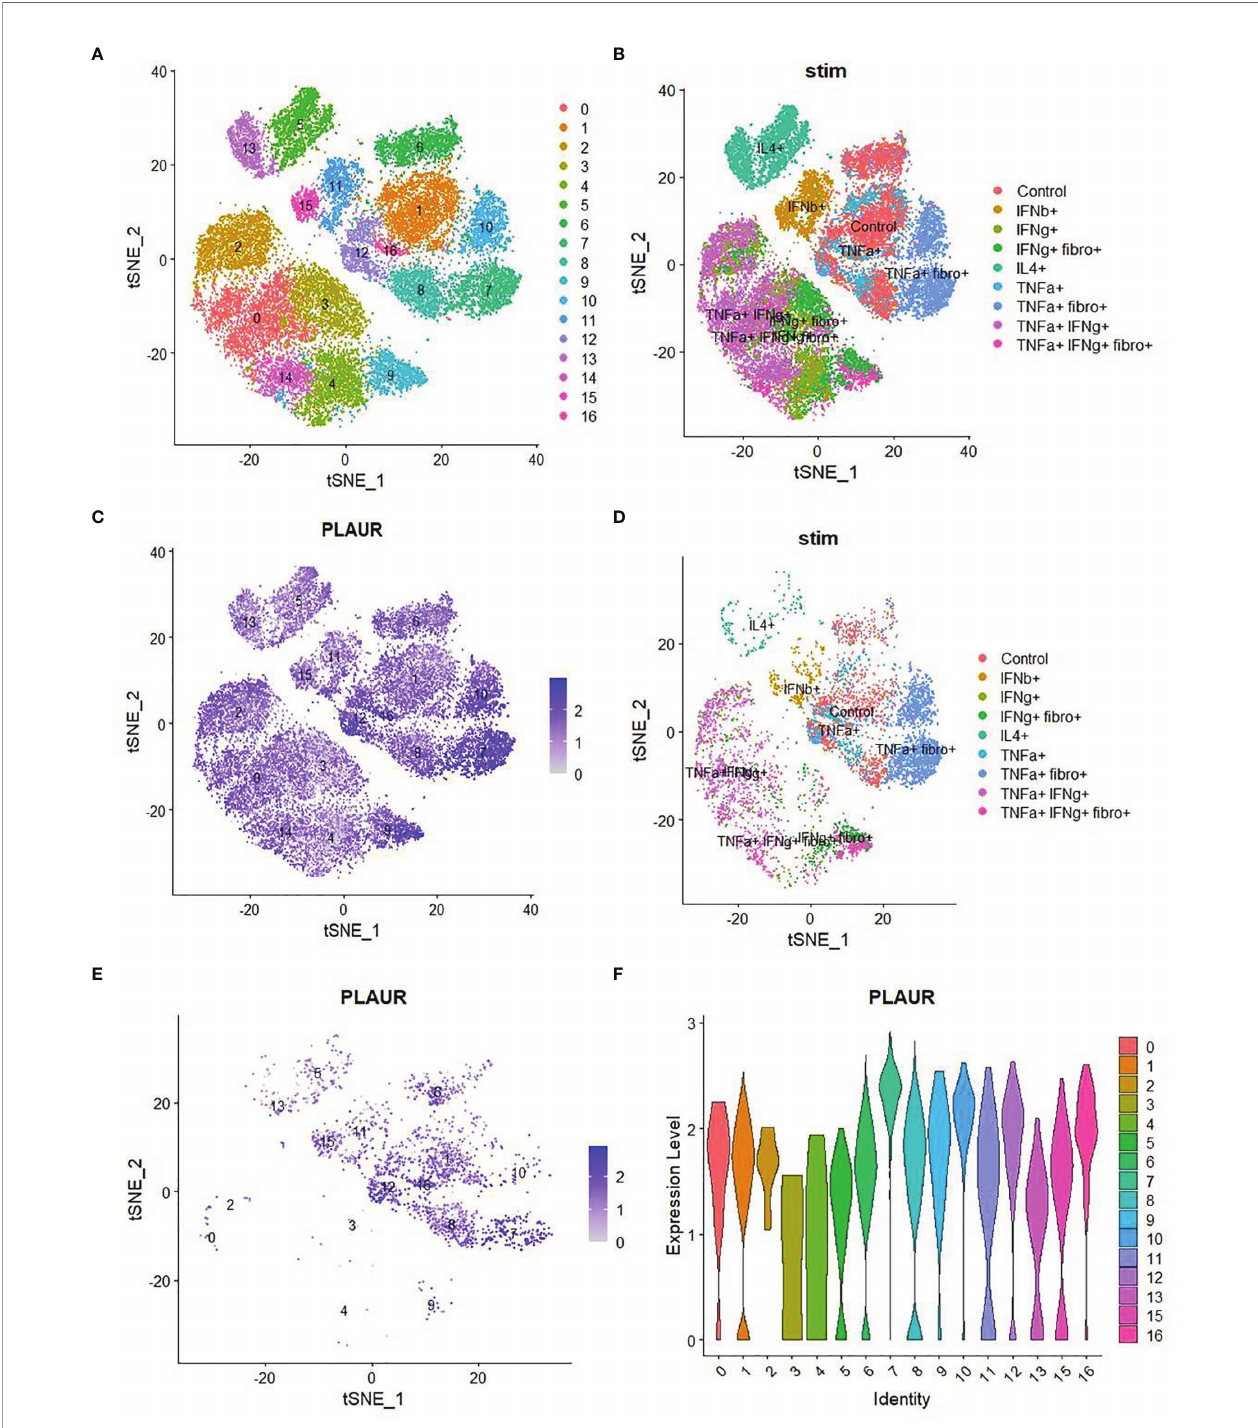
FIGURE 4 | Analysis of single-cell sequencing data to con fi rm the role of TNF a on myeloid expression of suPAR. (A) TSNE plot of scRNA-seq data (obtained from GSE168710) of macrophages grouped into various clusters based on their gene expression pro fi les. (B) TSNE plot of the same scRNA-seq data showing the different treatments to which the macrophages were exposed before sequencing. (C) TSNE plot showing the distribution of expression of the “ PLAUR ” gene in all the cells of the same dataset. (D) TSNE plot depicting the treatment conditions to which all the PLAUR high cells belong. (E) TSNE plot depicting the expression pattern of “ PLAUR ” speci fi cally in CD11c high HLA-DR low cells. (F) Violin plot highlighting the difference in expression of “ PLAUR ” between the different clusters of CD11c high HLA-DR low